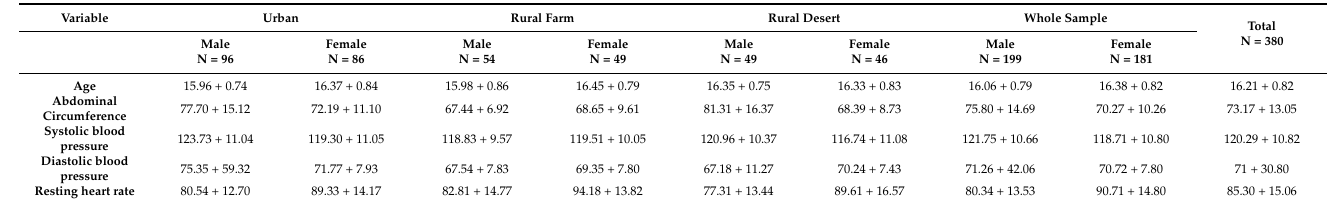
Table 1. Mean ± SD of the main dependent variables for the total sample and sub-samples.